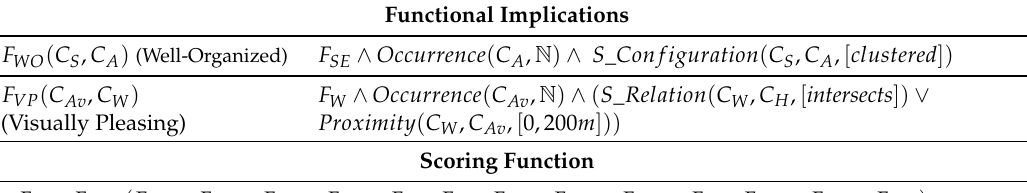
Table A3. Cont. Functional